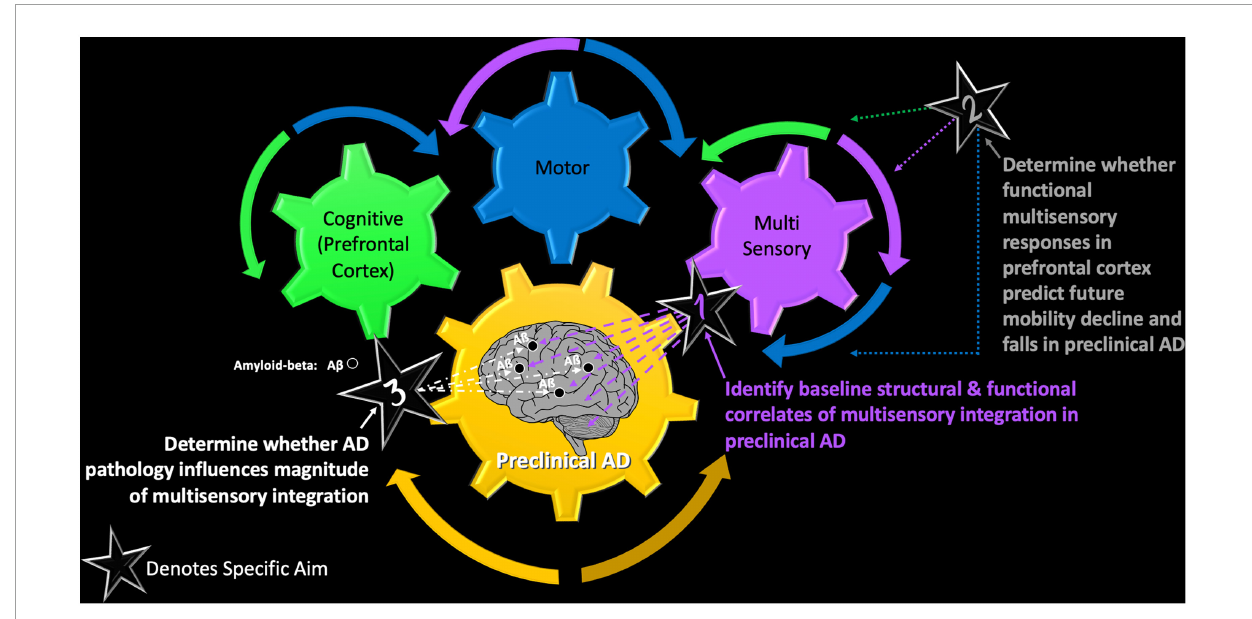
FIGURE2 The VSI Study – a conceptual model of the main objectives of the VSI Study and how each afford examination of the intersection of cognitive, motor, and multisensory functioning in healthy and pathological